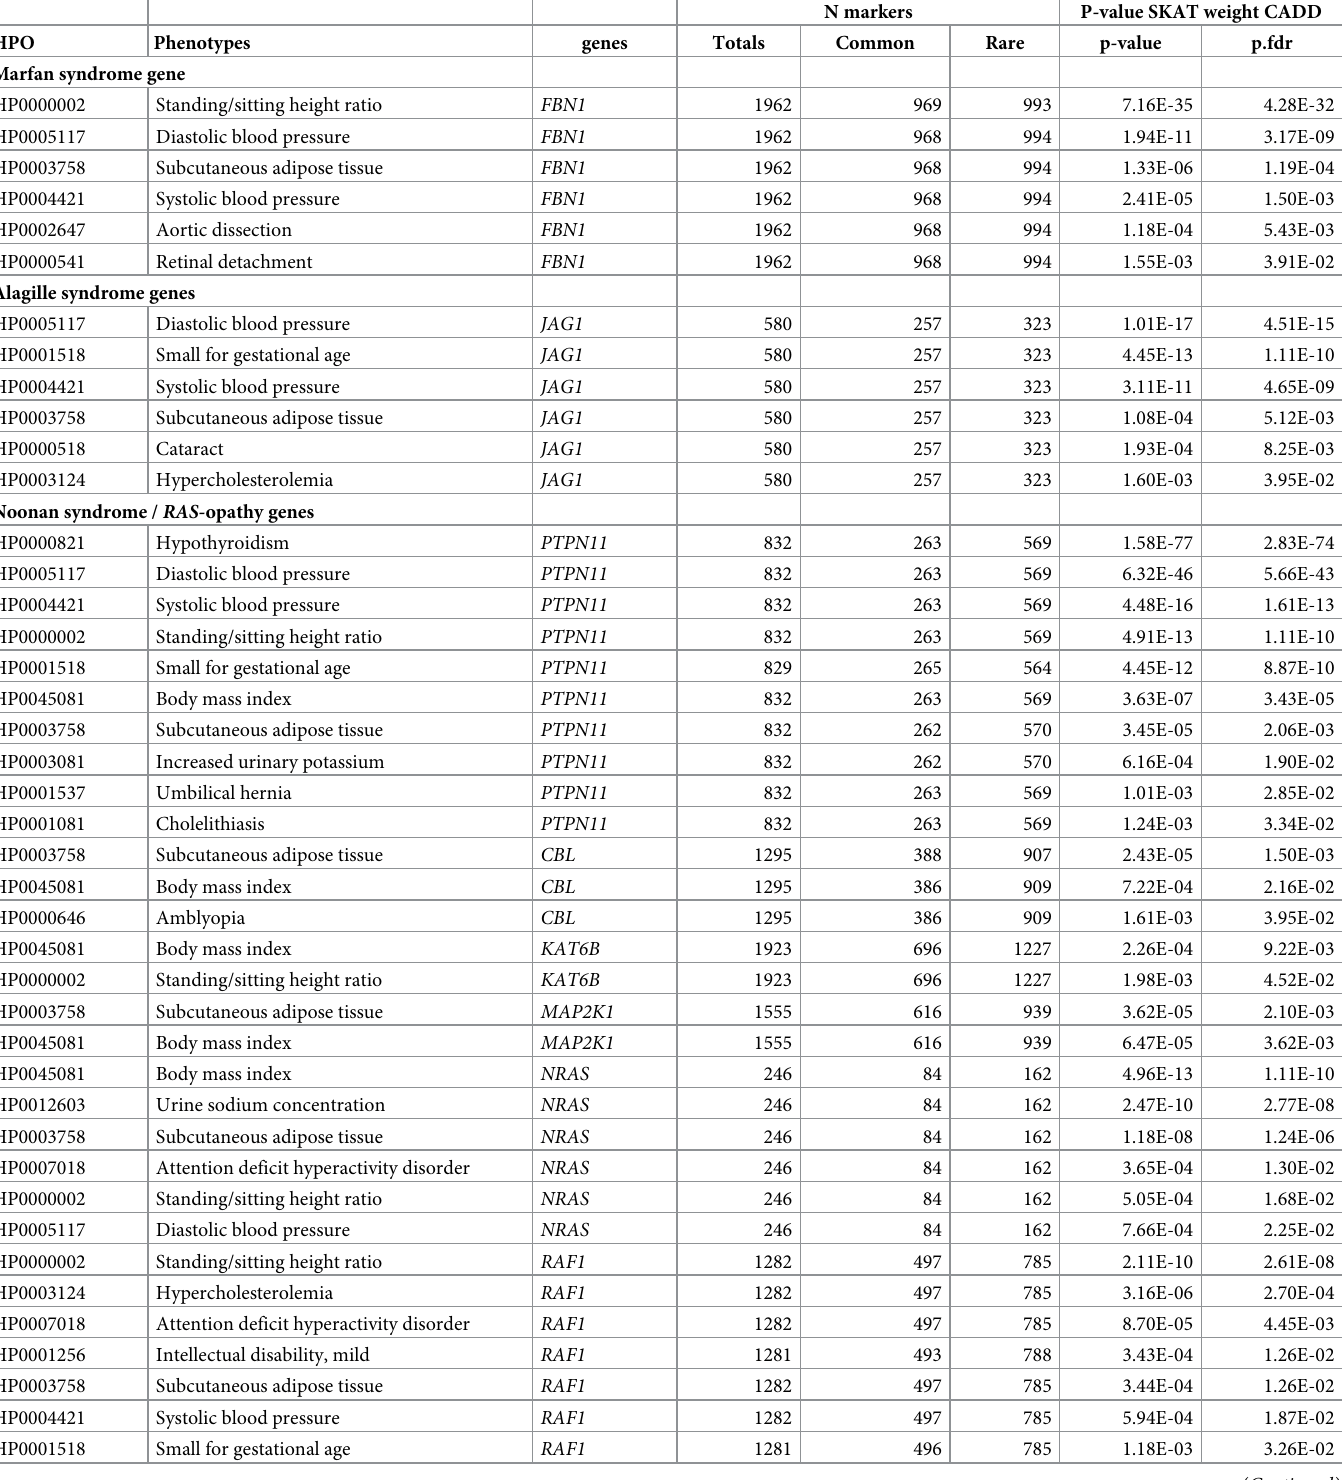
Table 2. Table of association between sets of associated phenotype–gene pairs after FDR correction (gene level association performed using SKAT test with variants weighted by their CADD score).